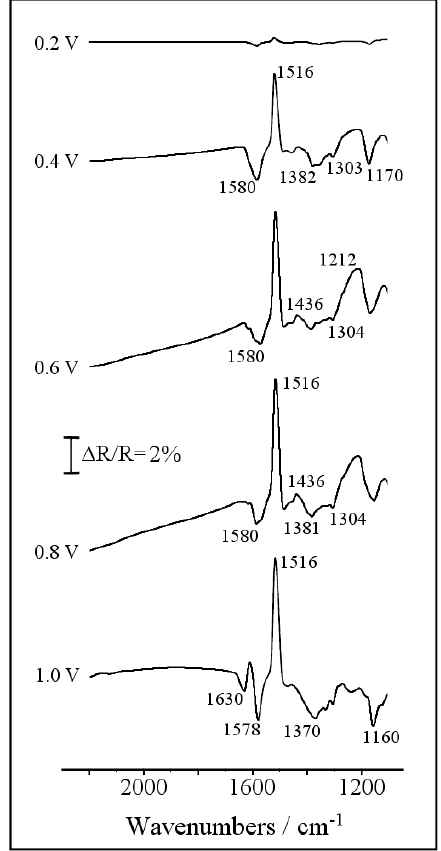
Figure 5. Set of in situ FTIR spectra collected during the oxidation of an electrochemically obtained poly(aniline-co-piperazine) film in 0.1 M of HClO 4 /D 2 O test solution. Reference potential 0.1 V. Sample potential labeled for each spectrum: 100 interferograms at each potential.